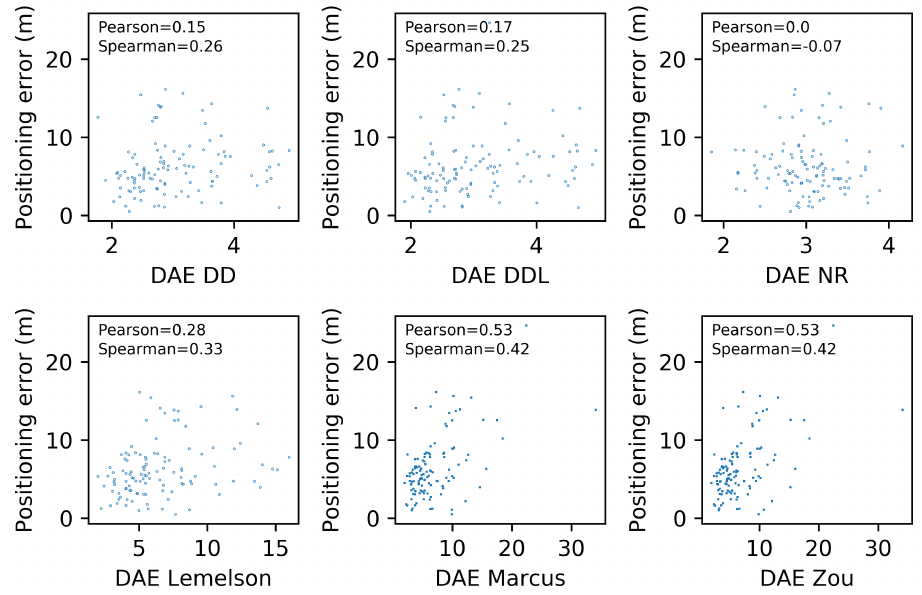
Figure 18. Scatterplots for five DAE methods and one baseline, depicting the DAE estimates against the actual positioning error values. Pearson’s correlation coefficient as well as Spearman’s rank correlation coefficient are indicated for each method. The validation set of the DSI dataset is